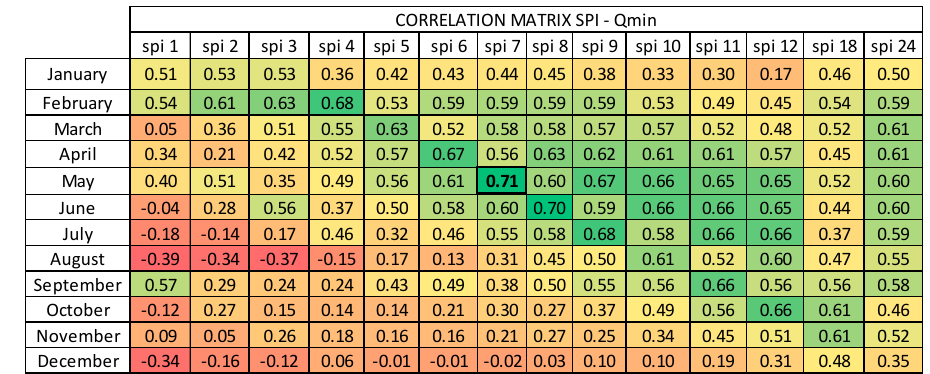
Figure 9. Correlation matrix SPI (Standard Precipitation Index) - Q min Figure 8. Correlation matrix SPI (Standard Precipitation Index) - Q min .